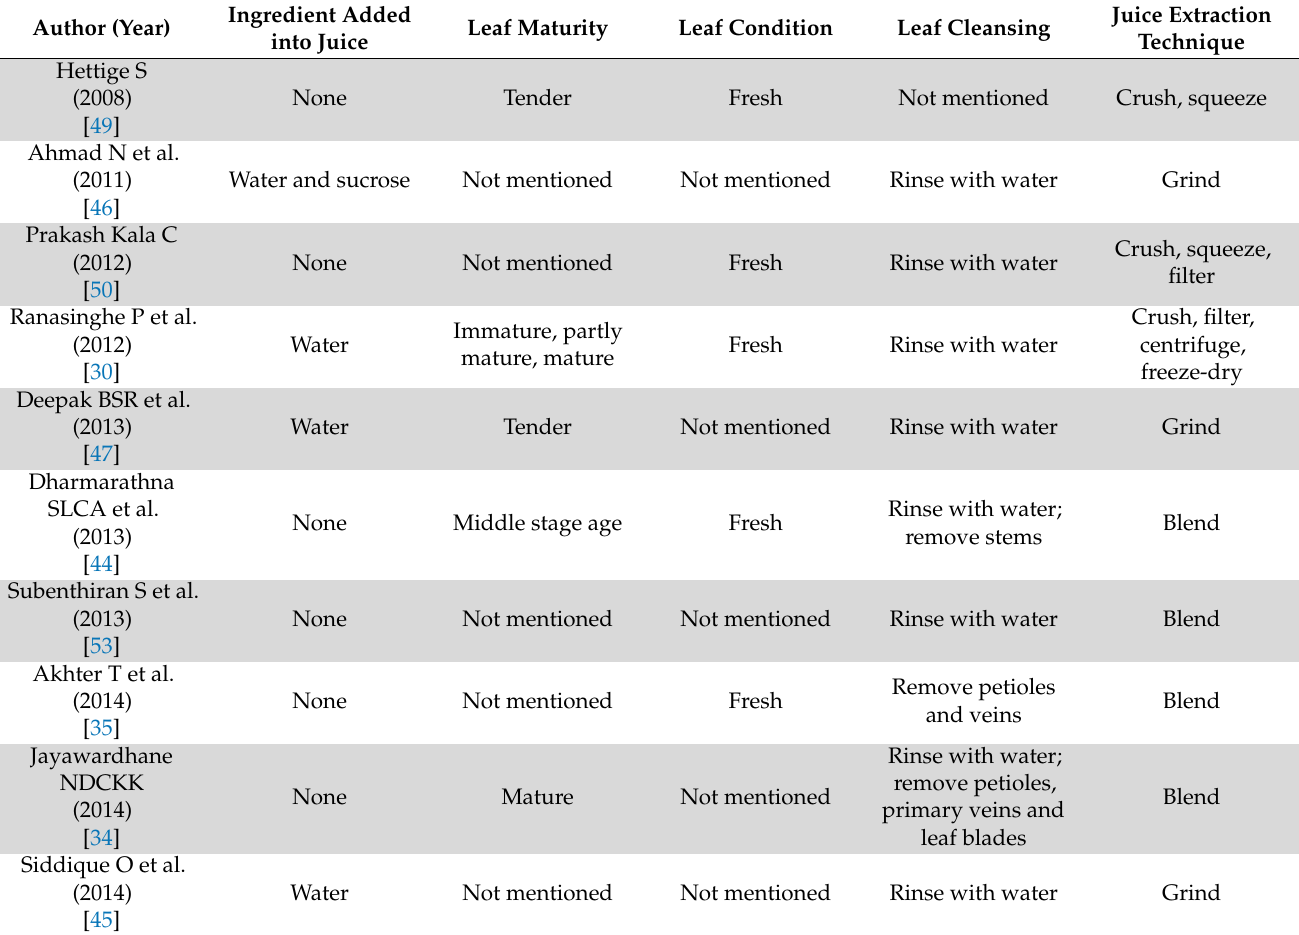
Table 3. Summary of juice preparations reported in the included